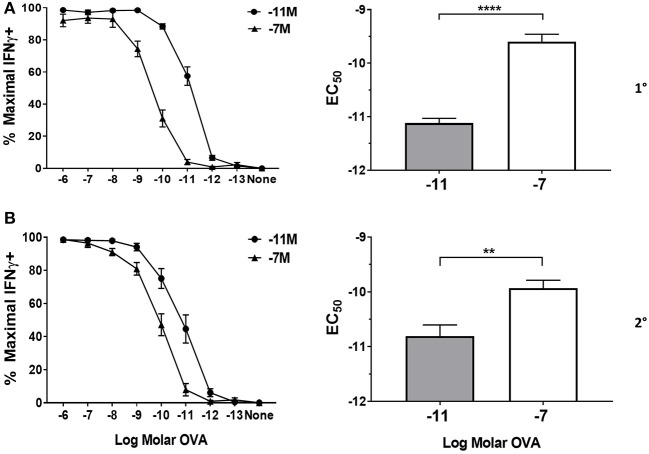
Peptide sensitivity of effector cells is regulated by the amount of antigen used for stimulation. Splenocytes from OT-I Rag2−/− mice were stimulated with irradiated C57BL/6 splenocytes pulsed with a high (10−7M) or low (10−11M) concentration OVA257−264 peptide. As a control, OT-I cells were cultured with splenocytes in the absence of peptide (NS). On day 5 post primary (A) and secondary (B) stimulation, IFNγ prodcution was assessed by intracellular cytokine staining (ICCS) following stimulation with a range of OVA257−264 peptide concentrations (10−6M−10−13M). The left panel shows the percent maximal IFNγ production (mean ± SEM). The right panel shows the amount of peptide needed to reach half the maximal (EC50, mean±SEM) percent of IFNγ-producing cells. Data are from 6 independent cell cultures. Significance was assessed by a two tailed unpaired t test. **p < 0.01, ****p < 0.0001.